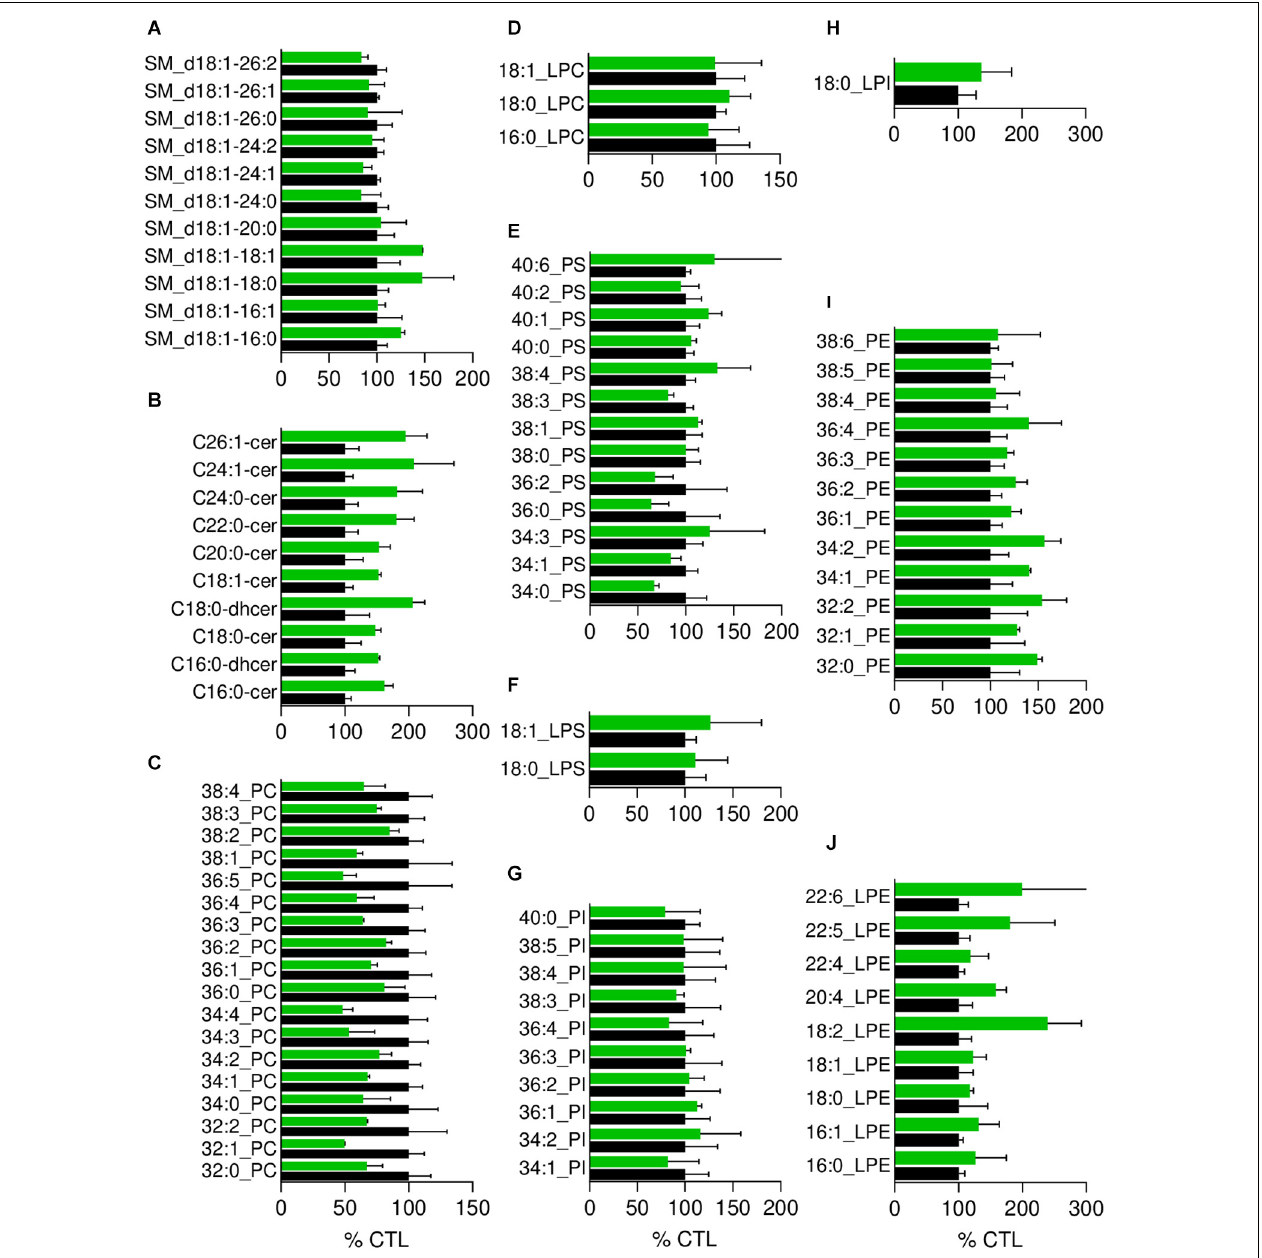
FIGURE 4 | The most obvious membrane lipid changes in pHypo β RBCs are an increase of ceramide species and a decrease of phosphatidylcholine species. Lipid species were assessed by HPLC-MS on washed, lysed and lipid-extracted RBCs. Content in sphingomyelin (d18:1 D-erythro-sphingosine backbone, SM; A ), ceramide (Cer) and dihydroceramide (dhcer; B ), phosphatidylcholine (PC; C ), lysophosphatidylcholine (LPC; D ), phosphatidylserine (PS; E ), lysophosphatidylserine (LPS; F ), phosphatidylinositol (PI; G ), lysophosphatidylinositol (LPI; H ), phosphatidylethanolamnine (PE; I ) and lysophosphatidylethanolamine (LPE; J ). Results are expressed as percentage of controls (CTL, mean of 4 donors). Data are means ± SD of 2 independent